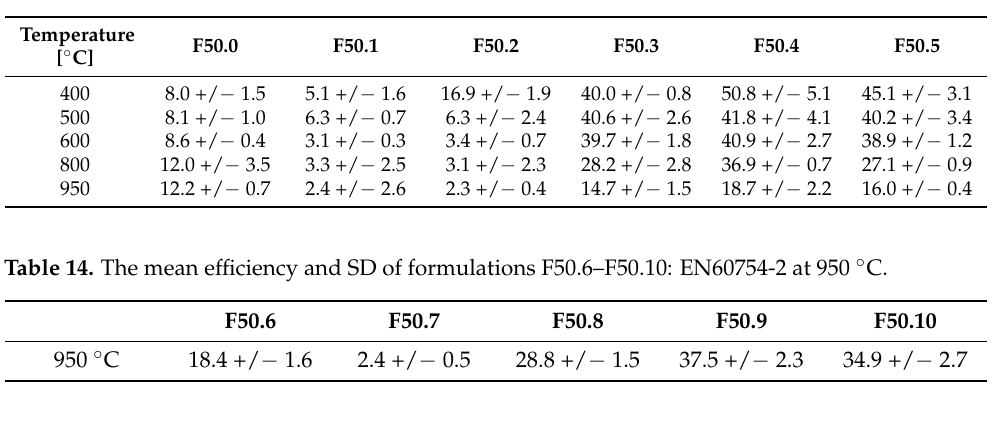
Table 13. The mean efficiency and the SD of formulations F50.0–F50.5: EN60754-2 at different temperatures.